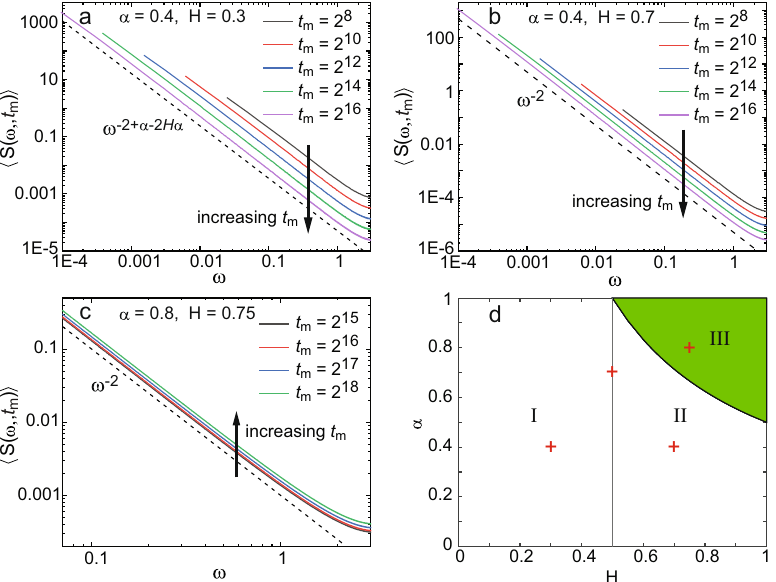
Fig. 3 Power spectral density of numerical simulations of fBM with heavy-tailed immobilization times. a Simulations for fi ve different measurement times with α = 0.4 and H = 0.3. The number of realizations is N = 10,000. Given that the fBM is subdiffusive ( H < 1/2), the PSD is predicted to scale as h S ð ω ; t m Þi (cid:2) t (cid:3)ð 1 (cid:3) α Þ